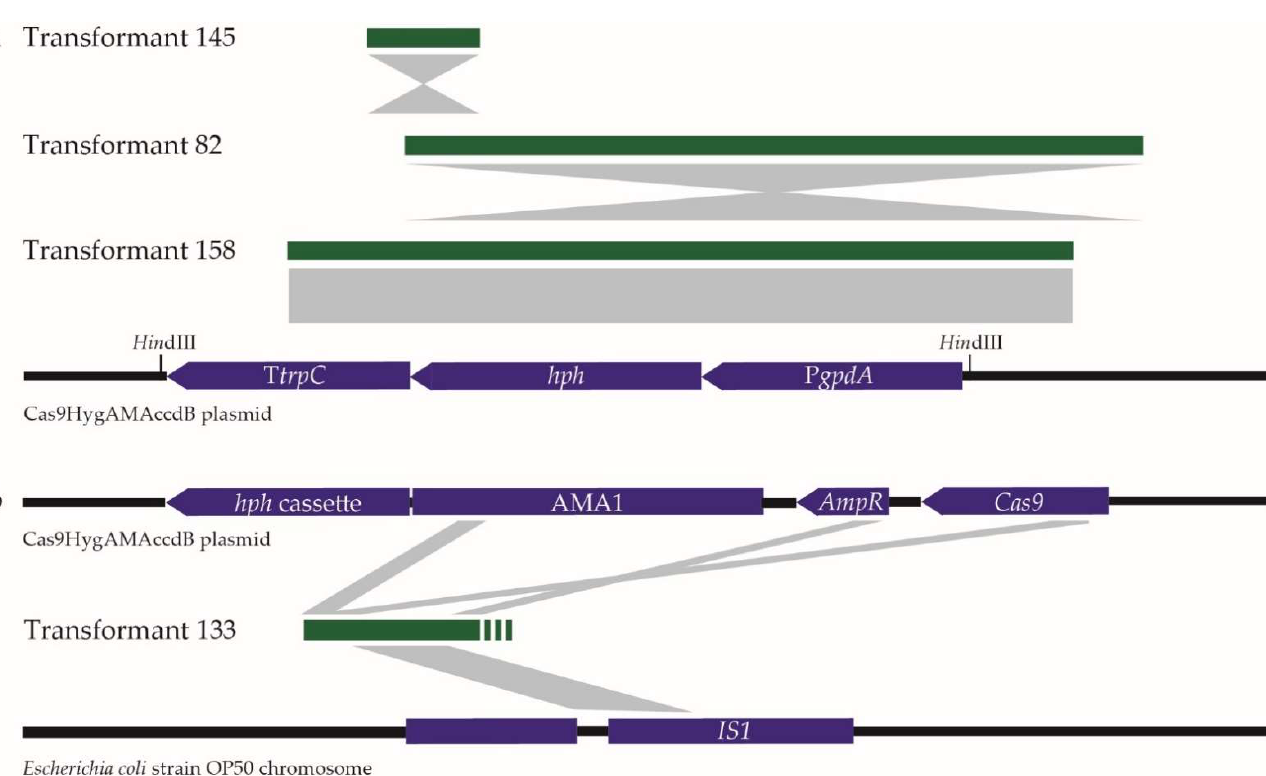
Figure 4. Insertions in Dothistroma septosporum CRISPR/Cas9 AflR transformants and matching sequences. ( a ) Insertions in transformants 145, 82, and 158 that match part of the hph (hygromycin B resistance gene) cassette from the CRISPR/Cas9 plasmid (Cas9HygAMAccdB). ( b ) Part of insertion in transformant 133 that matches different regions of the CRISPR/Cas9 plasmid and a region of an Escherichia coli strain OP50 chromosome. Insertions were identified by PCR analysis and PCR amplicon sequencing. Insertions indicated by green bars align to matching regions of the Cas9HygAMAccdB plasmid or E. coli chromosome. Grey rectangles or triangles underneath and above inser- tions indicate relative orientation compared to the AflR gene. Hin dIII restriction enzymes sites near the hph cassette are labelled. Black lines indicate part of the Cas9HygAMAccdB plasmid sequence or E. coli chromosome, and labelled purple bars indicate genes or plasmid components (T trpC ter- minator, hph cassette, P gpdA promoter, AMA1 autonomously replicating sequence, AmpR β-lac-